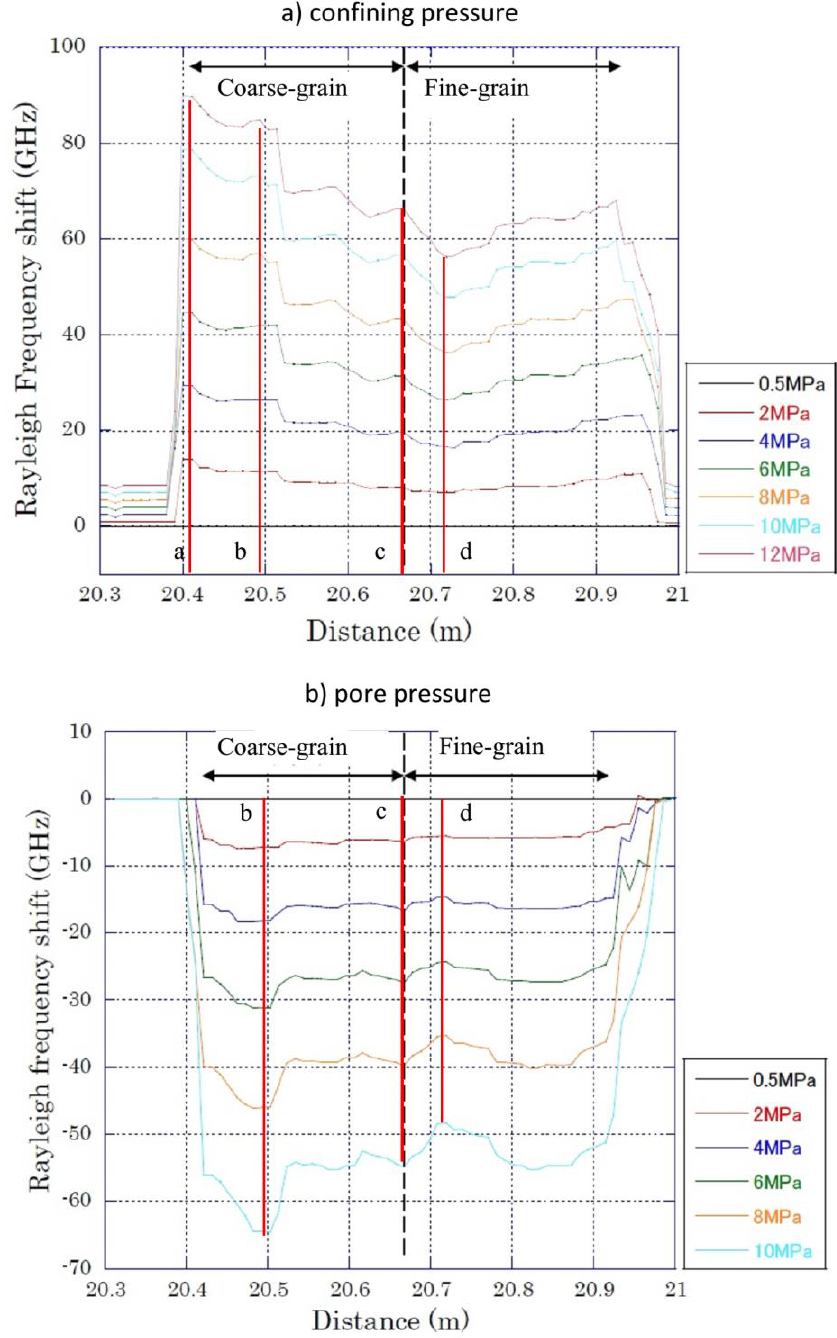
Figure 13. Tako core Rayleigh frequency shift measurements ( a ) showing clear trends in the two regions; ( b ) showing a comparatively more uniform response with increasing pore